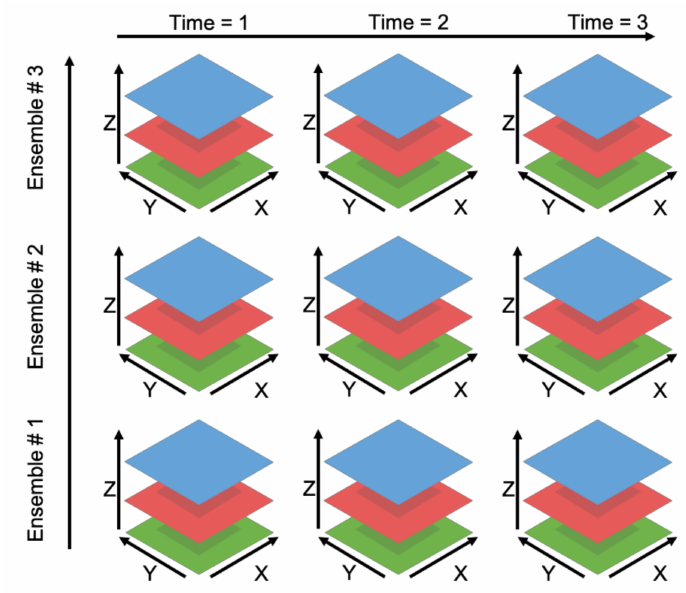
Figure 3. Five-Dimensional